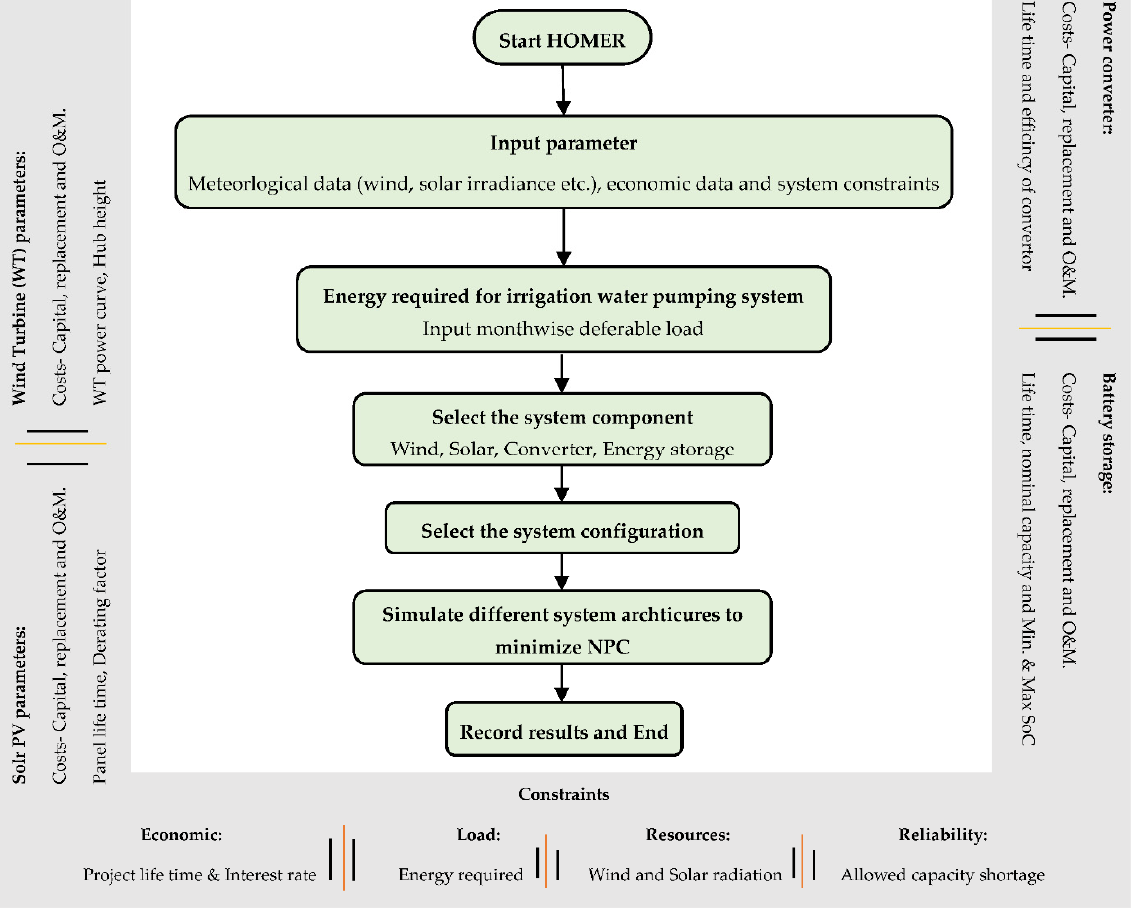
Figure 5. Homer process flow for the optimization of the hybrid renewable system. The process is repeated for each site, and the optimum system architecture is ob- tained with the economic analysis.